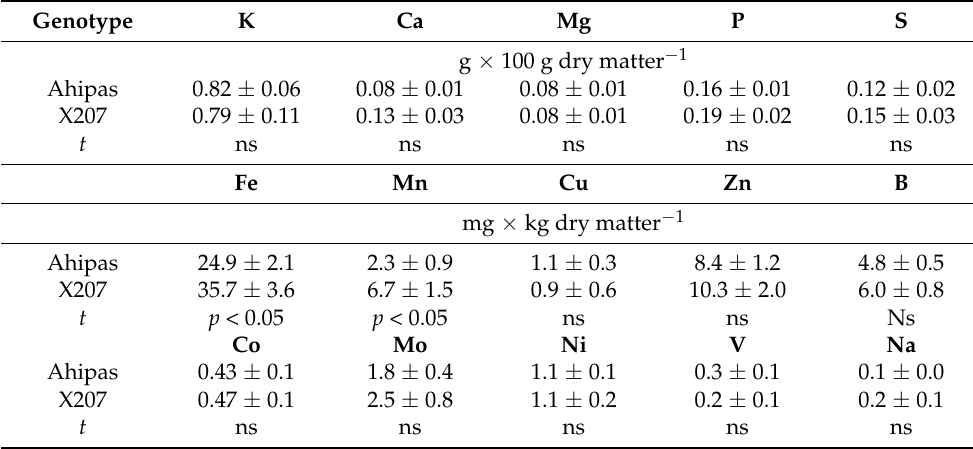
Table 7. Comparison of the concentration of minerals in roots from six ahipa accessions and the interspecific hybrid X207. Mean ± standard error. Statistical significance of the difference between both genotypes was determined by Student’s t -test.